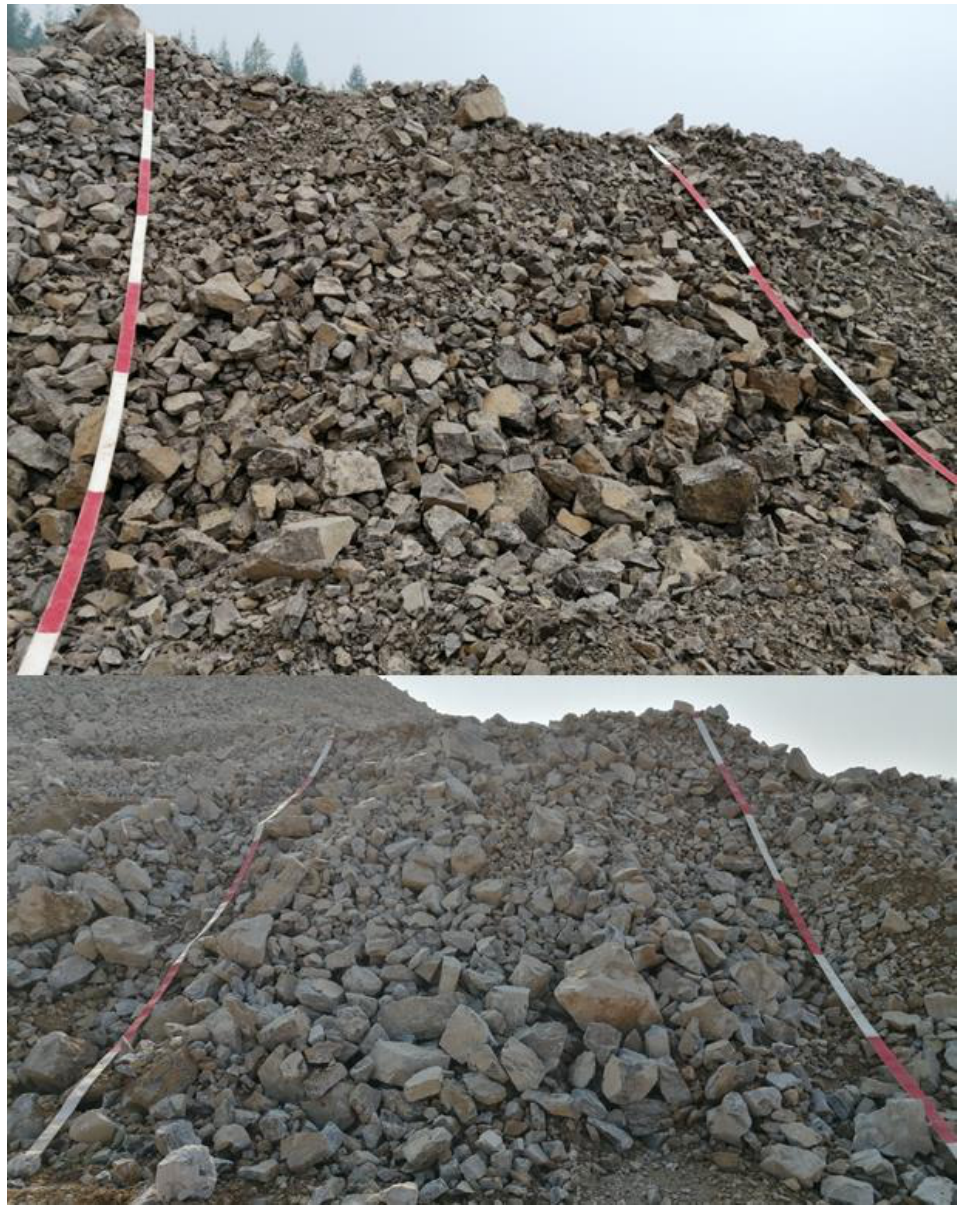
Figure 5. The area of the rock mass explosion.